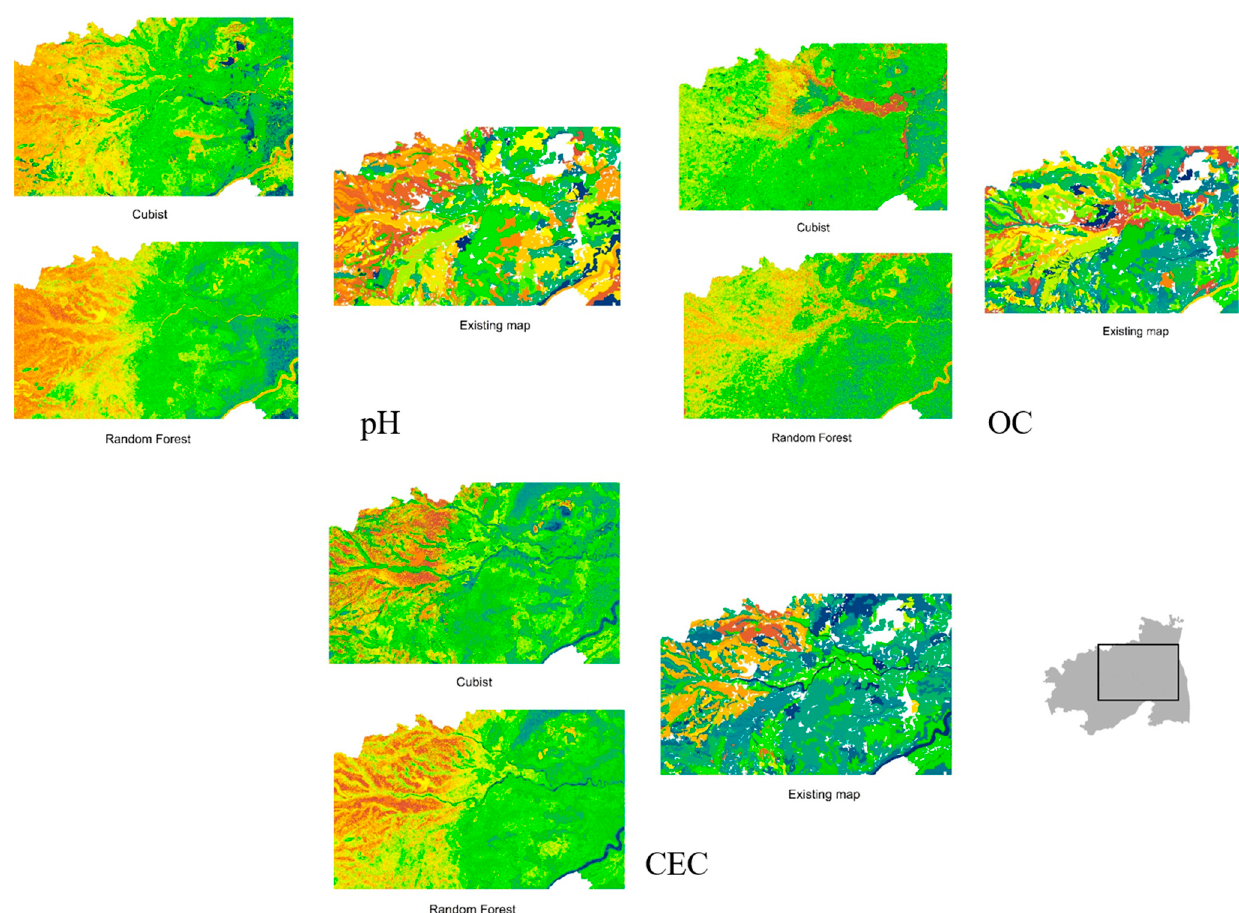
Figure 8. Visual assessment on the RF and Cubist predicted continuous variables maps. Similarly, when comparing the C5.0 and RF predictions with the existing maps, finer and more detailed boundary delineations were attributed to the C5.0 algorithm (Figure